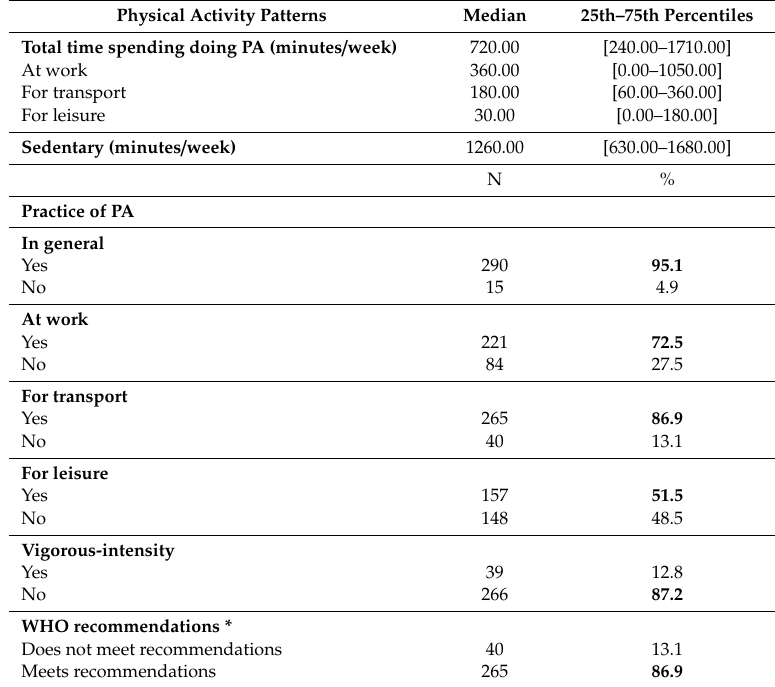
Table 4. Self-reported physical activity (PA) pattern (GPAQ questionnaire) among at-risk type 2 diabetes black and mixed-ancestry communities in Cape Town, 2018 (N =